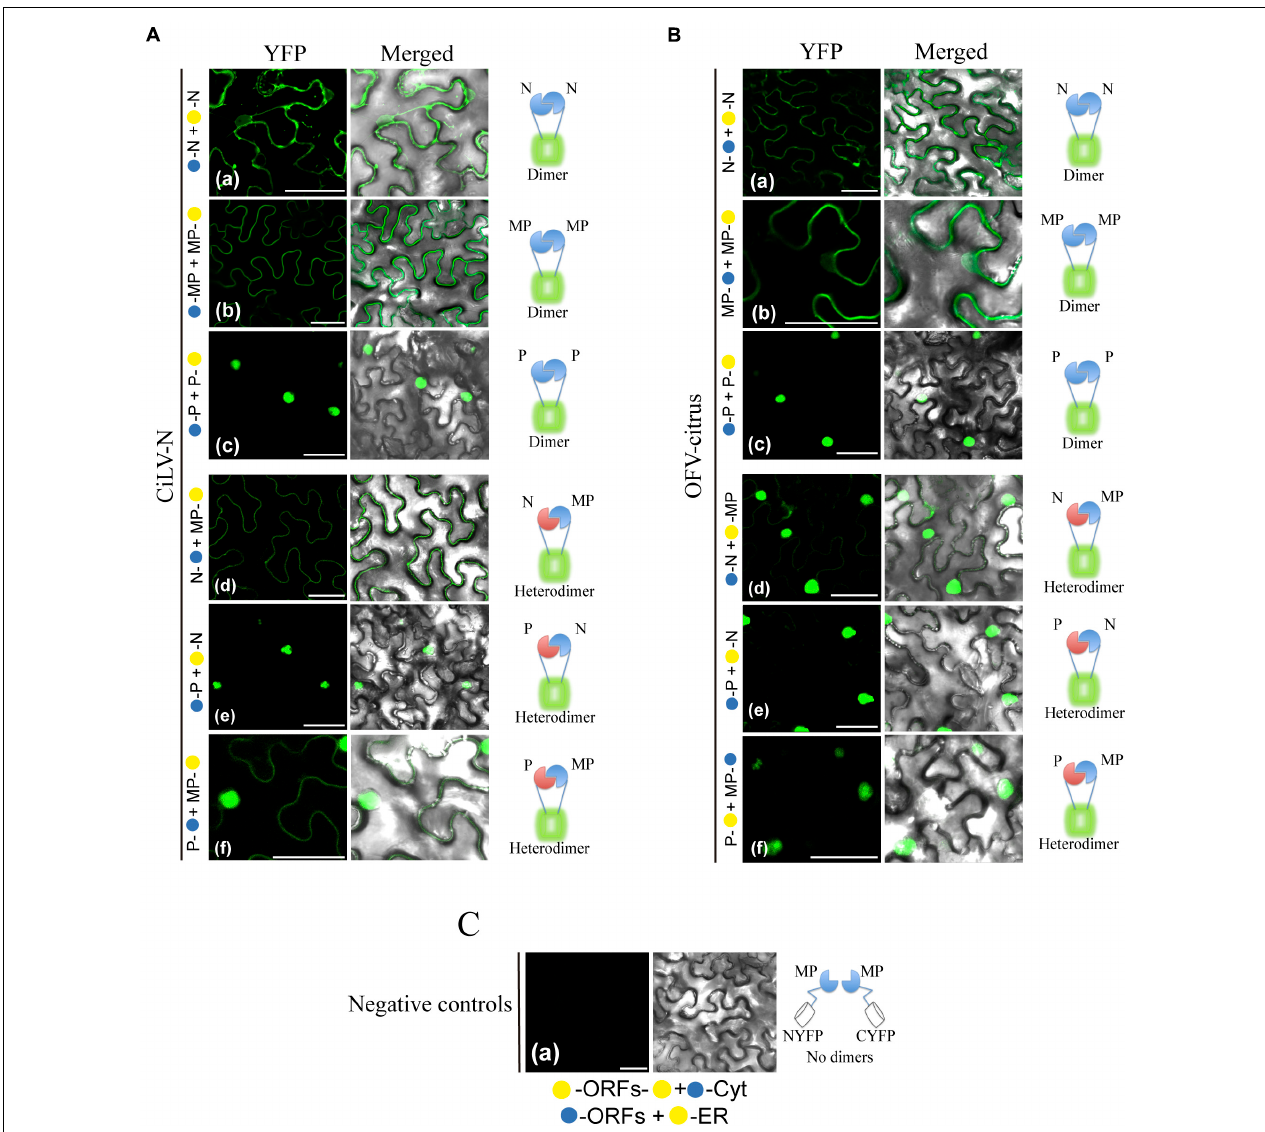
FIGURE 4 | BiFC analyses suggest dimer and heterologous interactions between dichorhavirus MP, N, and P. CiLV-N and OFV-citrus Ns, Ps and MPs carrying N-terminal ( • ) or C-terminal ( • ) YFP fragments fused at their N- ( • / • –ORFs) or C-termini (ORFs- • / • ) were transiently co-expressed in N. benthamiana leaves by agroinfiltration. Confocal microscopy images corresponding to the representative fusion protein pair combination assayed for dimeric and heterologous interactions. Representative protein pair combinations are indicated at the left of each image; all combinations performed are shown in Tables 2 , 3 . All images contain two pictures corresponding to the YFP signal or merged with bright field. (Aa) CiLV-N and (Ba) OFV-citrus N dimerizations with YFP signal located in the nucleus and cytoplasm. (Ab) CiLV-N and (Bb) OFV-citrus MP dimerizations with YFP signal located along the cell periphery and also visualized into the nucleus. (Ac) CiLV-N and (Bc) OFV-citrus P dimerizations with YFP signal exclusively localized into the nuclei. (Ad) CiLV-N N-MP intra-association with YFP signal distributed along the cell periphery, while for OFV-citrus N-MP (Bd) intra-association the YFP signal is more evident into the nuclei, but also located throughout cytoplasm. (Ae) CiLV-N and (Be) OFV-citrus P-N associations showing the YFP fluorescence reconstitution into the nuclei. (Af) CiLV-N P-MP association results in YFP signal in the nucleus and distributed along the cell periphery, while for OFV-citrus P-MP (Bf) , the YFP signal is exclusively into the nucleus. (C) Negative controls correspond to the expression of the dichorhavirus proteins in combination with Cyt or ER BiFC vectors. The left of each image has a representative scheme of the positive (dimers) or negative (no dimers) interaction corresponding to all proteins assayed. All images displayed are representative of at least three independent experiments. Bars correspond to 50 µ